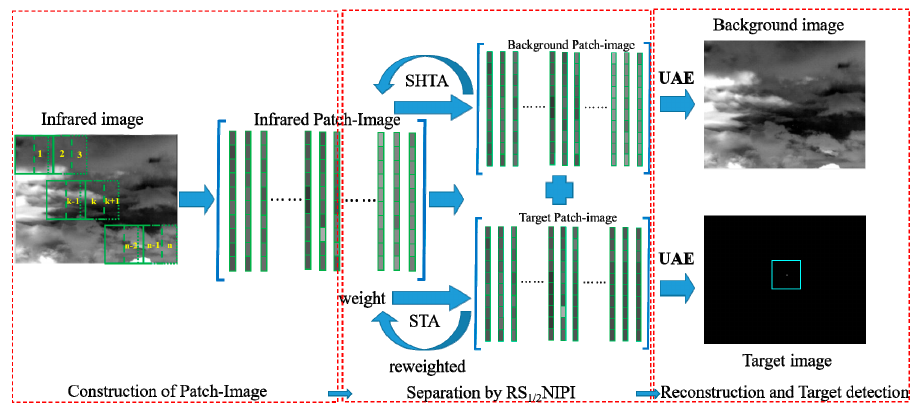
Figure 4. The diagram of the proposed RS 1/2 NIPI model in this paper.